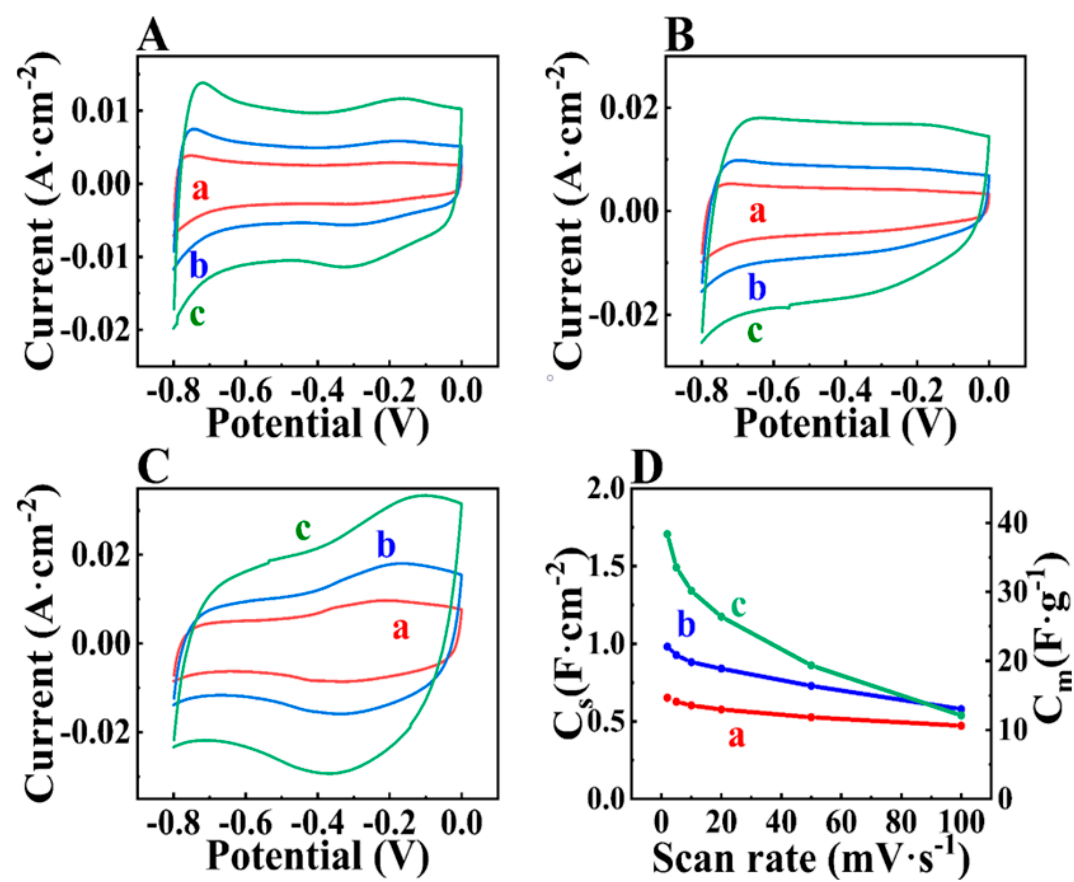
Figure 7. ( A – C ) CVs for ( A ) composite 1, ( B ) composite 2 and ( C ) composite 3 at scan rates of (a) 5, (b) 10, (c) 20 mV·s − 1 , ( D ) capacitance versus scan rate for (a) composite 1, (b) composite 2, (c) composite 3.